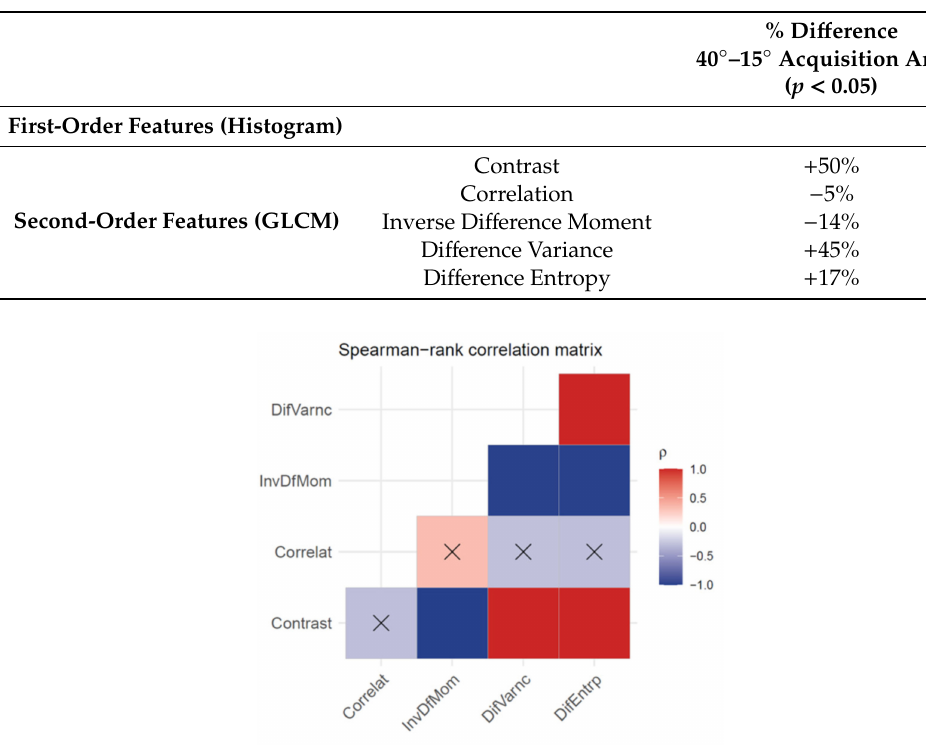
Table 2. Di ff erences between feature median values calculated from the high-resolution (40 ◦ acquisition angle) and standard (15 ◦ acquisition angle) DBT images. Only significant di ff erences are reported ( p < 0.05, Wilcoxon signed-rank test).